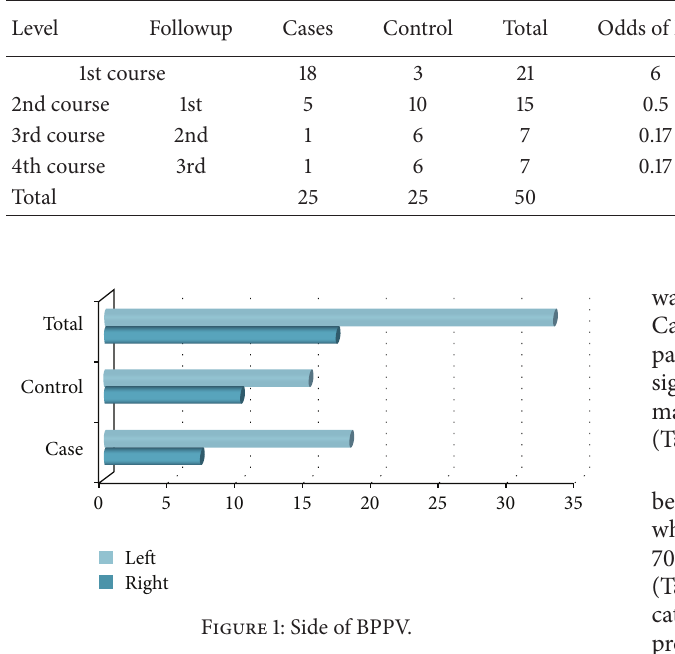
Table 5: Dose response relationship between Epley’s maneuver and controls among BPPV patients.